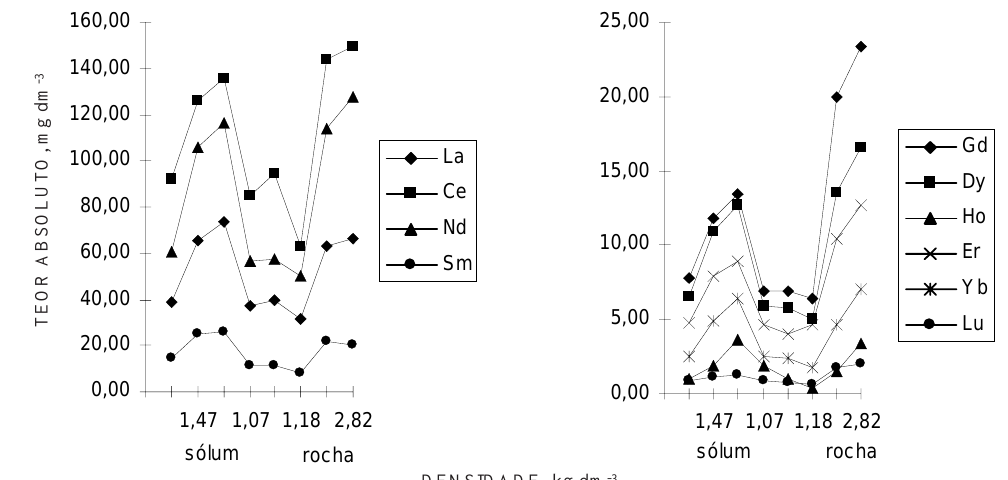
Figura 5. Diagramas de distribuição dos ETR em função da densidade para o perfil 2 (PVe).